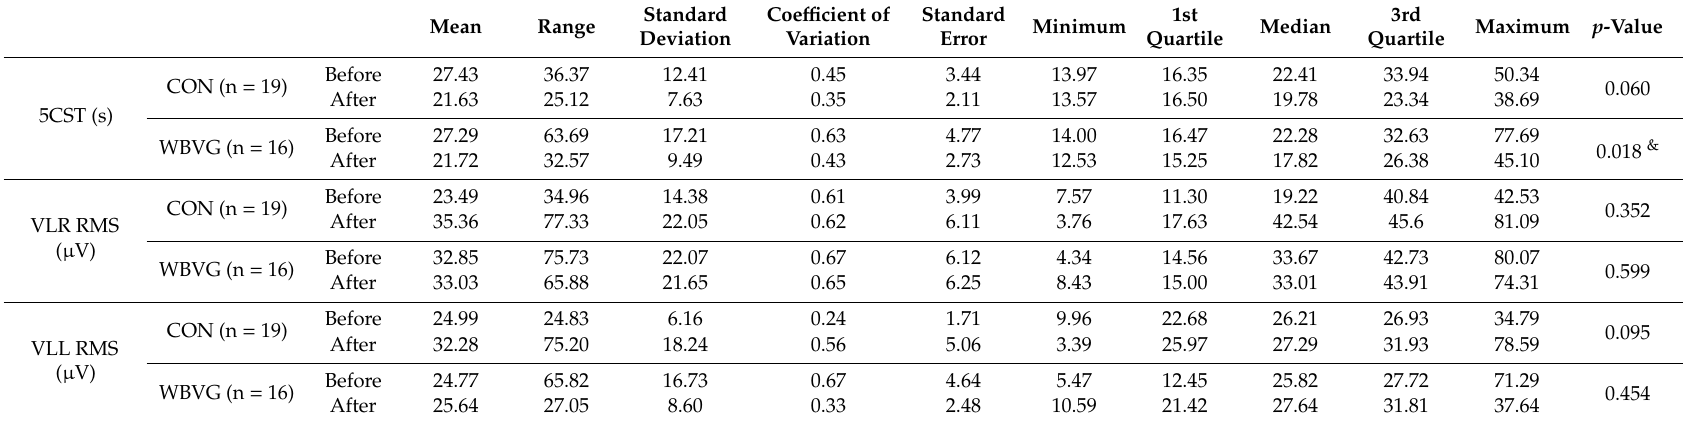
Table 2. Descriptive statistics for the five-repetition chair stand test and right and left vastus lateralis electromyography during the five-repetition chair stand test for CON and